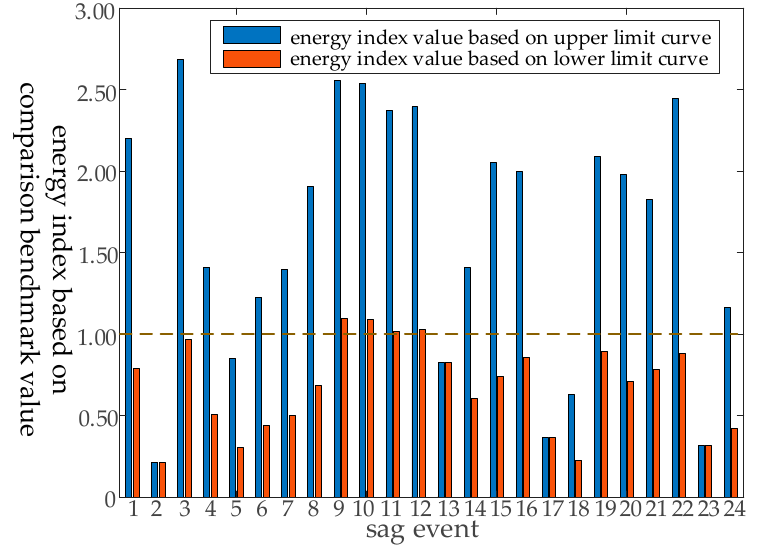
energy index value based on upper limit curve energy index value based on lower limit curve